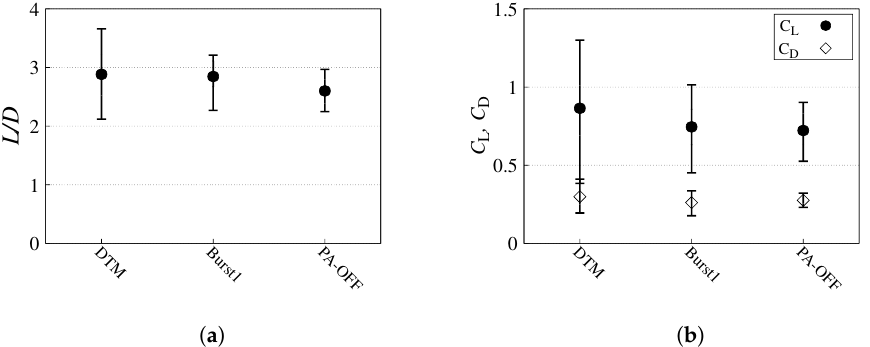
Figure 19. Aerodynamic characteristics in the DTM and the reference cases at α = 16. ( a ) Lift- to-drag ratio ( L / D ). ( b ) Lift and drag coefficients ( C L and C D ).